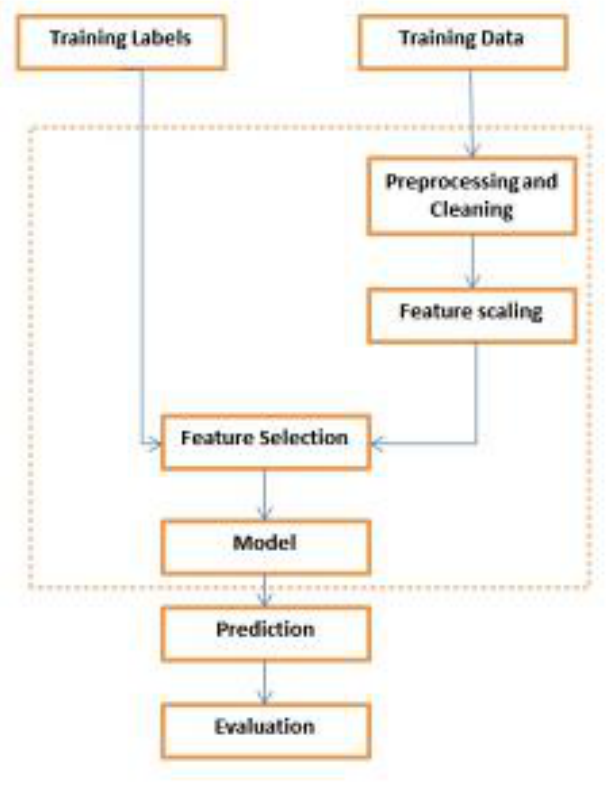
Fig. 1. Flowchart of